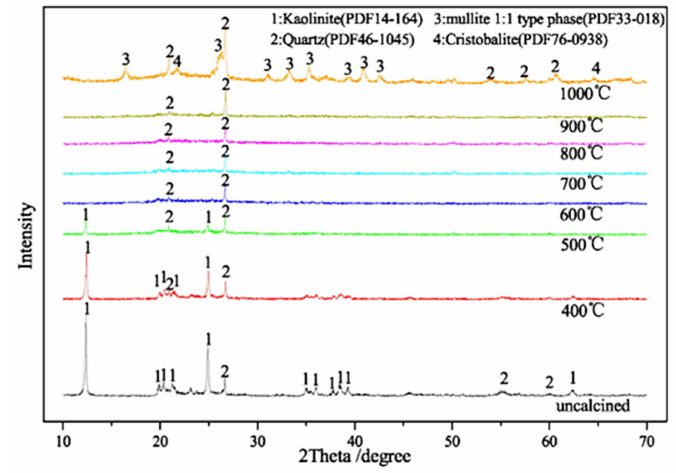
Figure 4. XRD patterns of coal gangue calcined at different temperatures (grinding for 30 min; holding time 2 h; heating rate 50 ◦ C/min) [46].